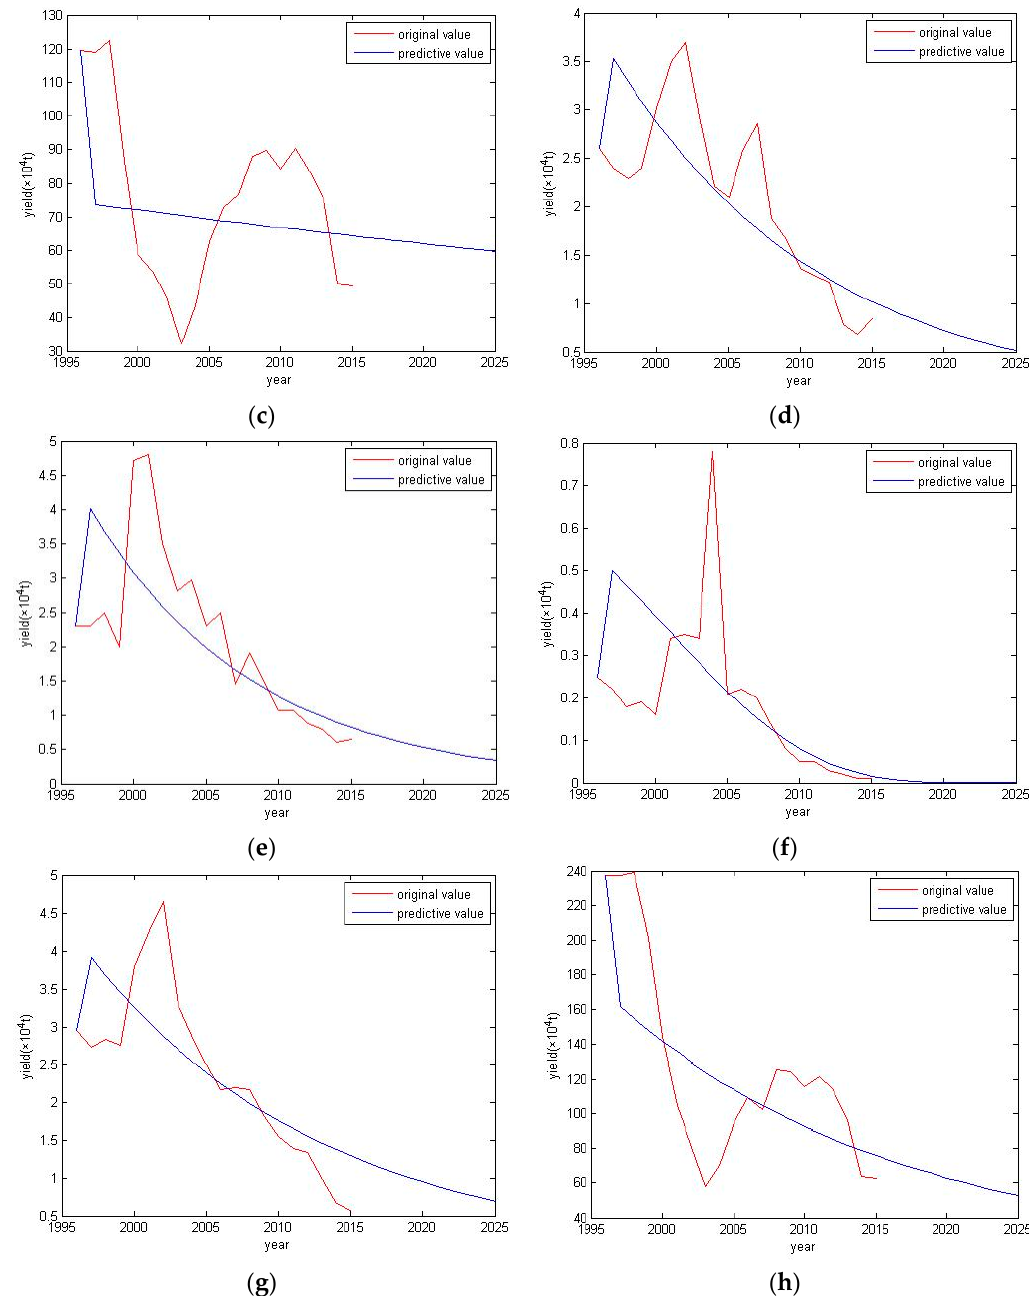
Figure 3. Graph showing crops yield developed from historic data and predicted with the GM (1,1) model in Beijing: ( a ) Rice; ( b ) Wheat; ( c ) Maize; ( d ) Tuber; ( e ) Beans; ( f ) Cotton; ( g ) Peanuts; ( h ) Total grain. The relevant parameters and the model test related to the prediction process using the GM (1,1) model are shown in Table 8.